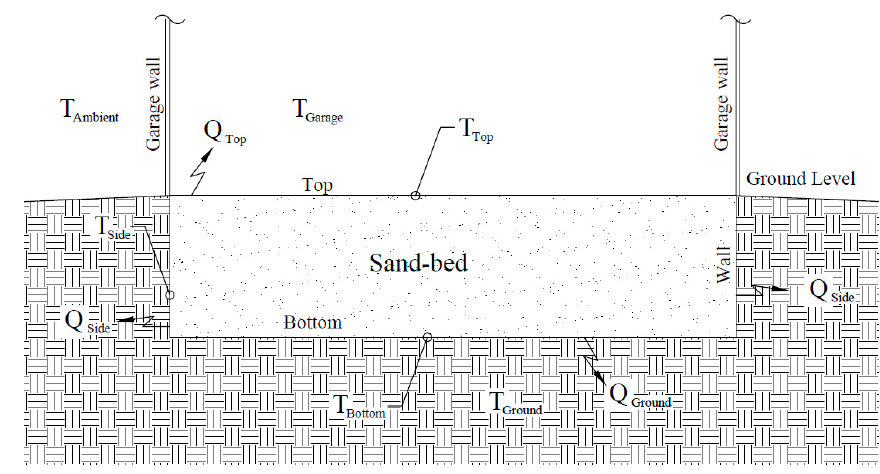
Figure 9. Diagram of sand-bed environmental variables.